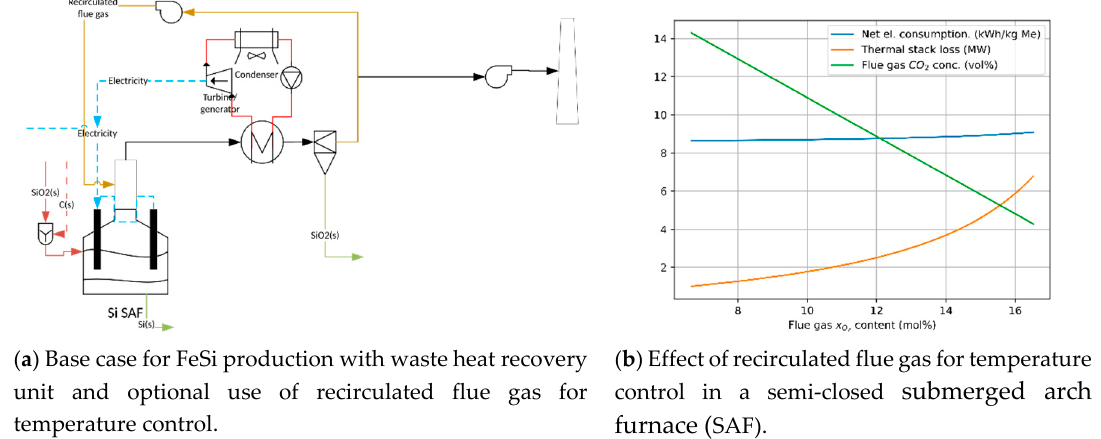
Figure 8. FeSi production—base case. Semi-closed furnace with and without recirculated flue gas. See Tables 2 and 3 for design parameters.